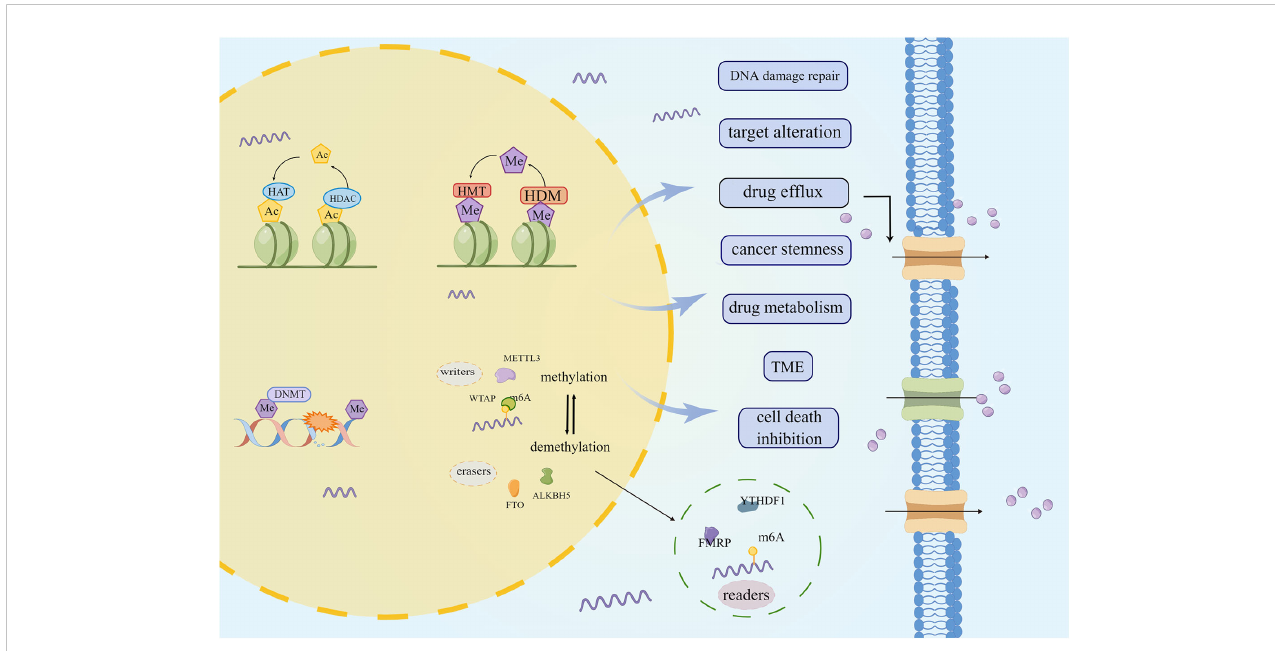
FIGURE 7 The role of epigenetic modi fi cation in chemoresistant CRC. DNA methylation, RNA methylation, histone methylation, deacetylation, etc., lead to CRC chemoesistance by promoting drug ef fl ux, changing drug metabolism and cell death and other